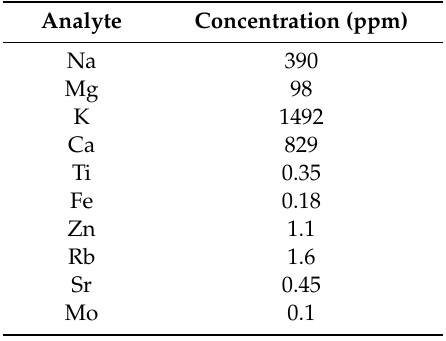
Table 1. Metal ions present in whey permeate at concentrations higher than 0.1 ppm, determined by semiquantitative ICP-MS.